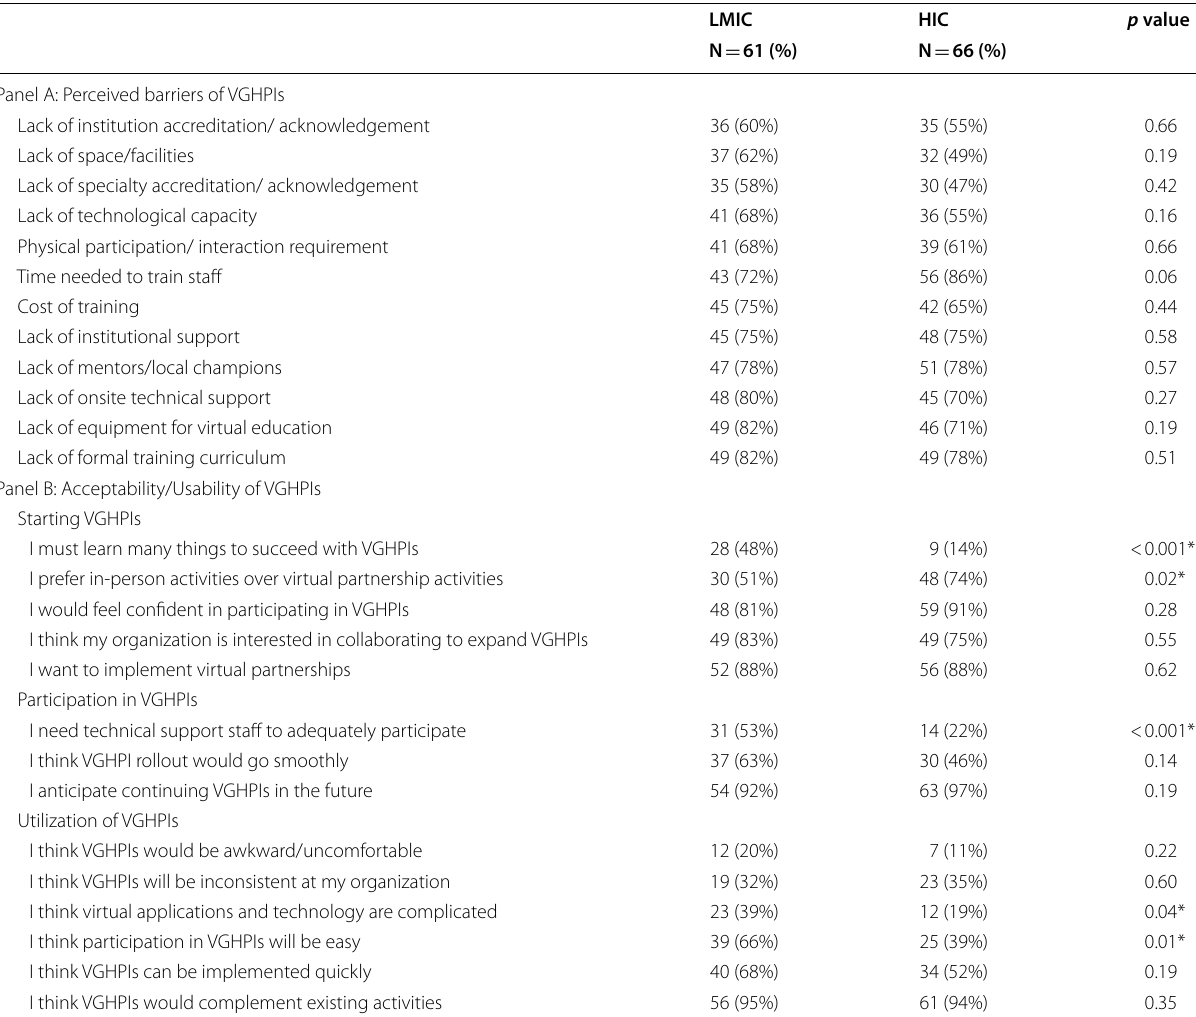
Table 3 Perceived barriers and acceptability of virtual global health partnership initiatives (VGHPIs) among respondents